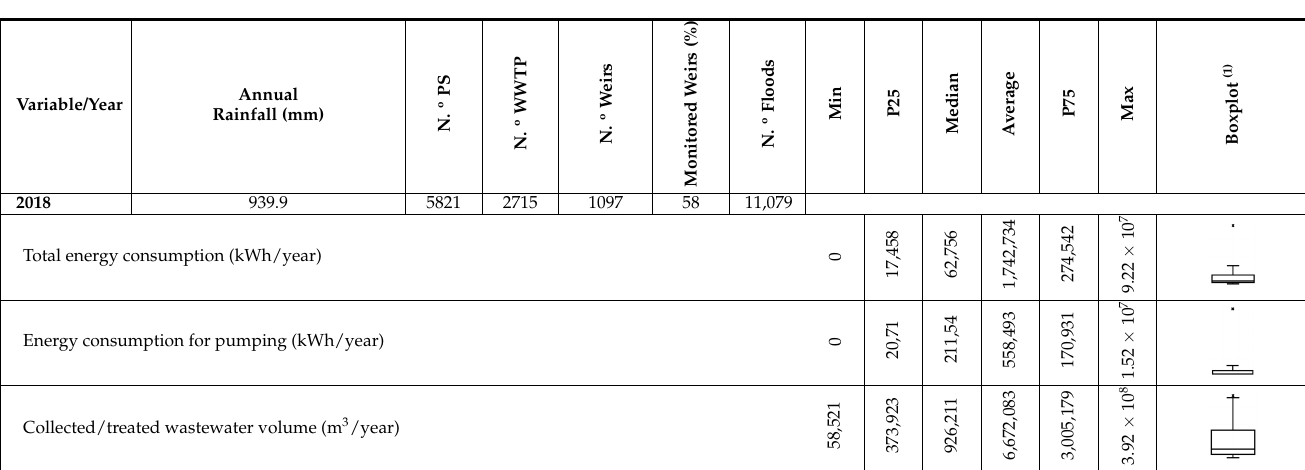
Table A5. National characterization for the evaluation of the W ‐ E ‐ G nexus for 2018.